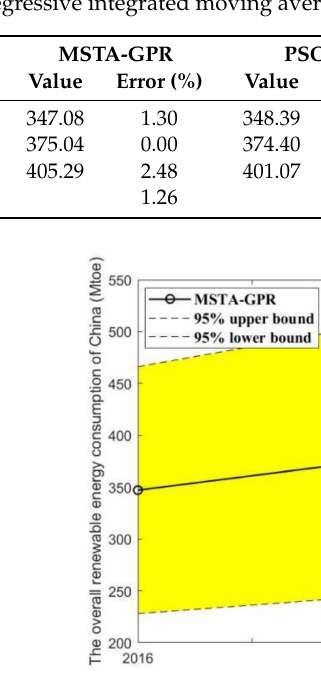
Table 4. Consumption prediction for overall renewable energy of China from 2006 to 2018 (Mtoe).